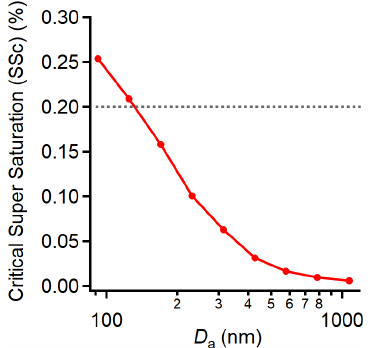
Figure 3. An example of the calculation of the size-resolved critical supersaturation